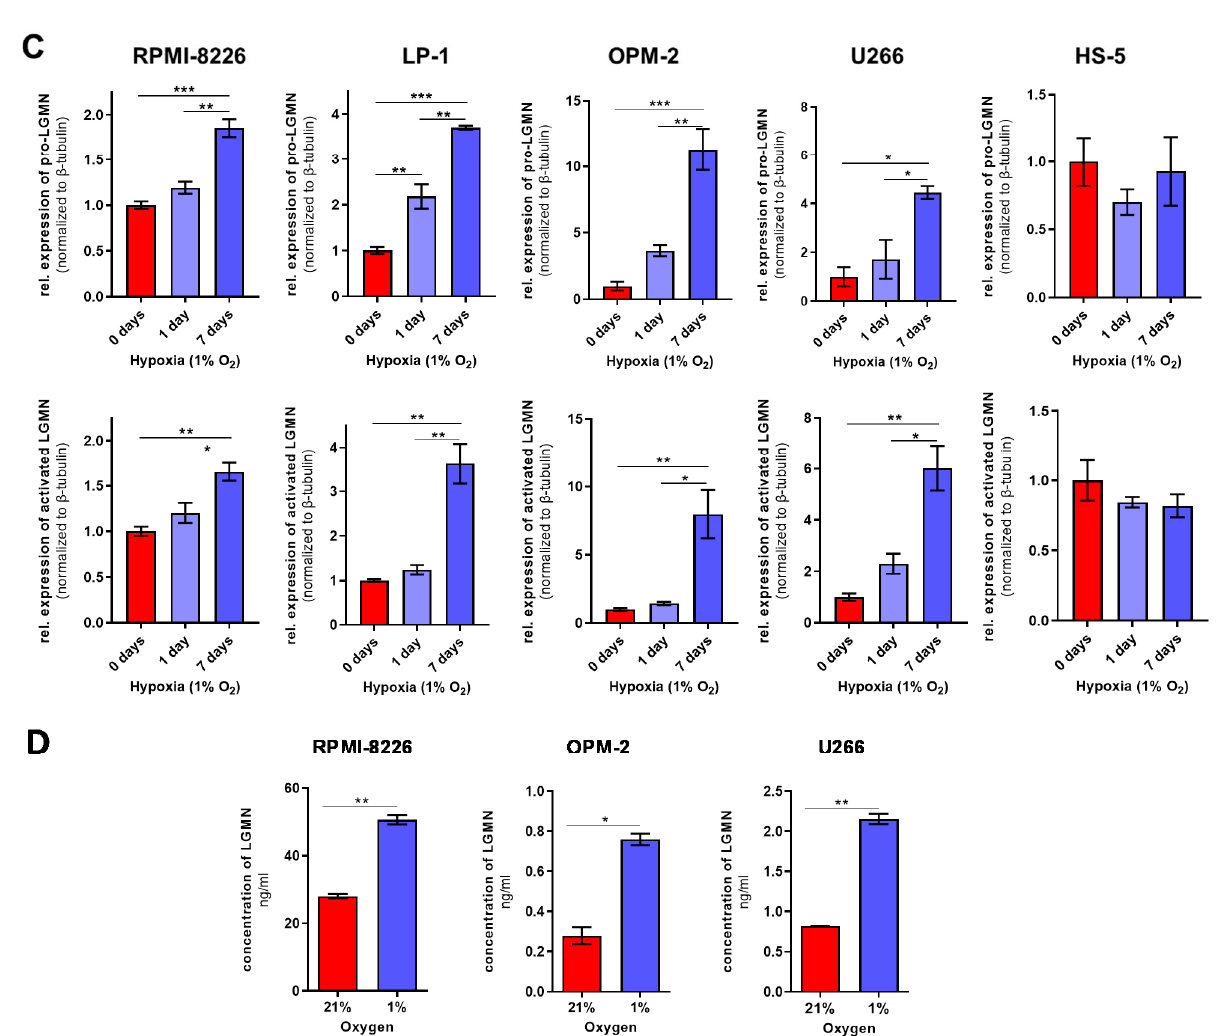
Figure 6. MM-specific upregulation of the cysteine protease legumain (LGMN) in chronic hypoxia: Four MM cell lines and the bone marrow stromal cell line HS-5 were cultured under hypoxic conditions (1% O 2 ) and analyzed at day 0, 1 and 7 for protein and mRNA expression. ( A ) Relative LGMN mRNA levels in MM cell lines, normalized to TATA-box-binding protein ( TBP ) mRNA levels. * p < 0.05; ***, p < 0.001. ( B ) Representative Western blots for LGMN at 56 kDa (pro-LGMN) and 37 kDa (activated LGMN). β -tubulin served as a loading control. ( C ) Densitometric quantifications of LGMN expression (pro-LGMN and active LGMN). Signals were normalized to β -tubulin expression. Bar graphs represent the mean ± SEM of three independent experiments. One-way-ANOVA with Bonferroni’s post-hoc test. *, p < 0.05; **, p < 0.01; ***, p < 0.001. ( D ) The extracellular concentration of LGMN in RPMI-8226, OP;-2 and U266 cells was assessed by enzyme-linked immunosorbent assay (ELISA) in the supernatant under normoxic and chronic hypoxic conditions. Extracellular concentration of LGMN [ng/mL] in RPMI 8226, OPM 2 and U266 cells. Bar graphs indicate the mean ± SEM of three technical replicates. Unpaired student’s t -test, *, p < 0.05; **, p <